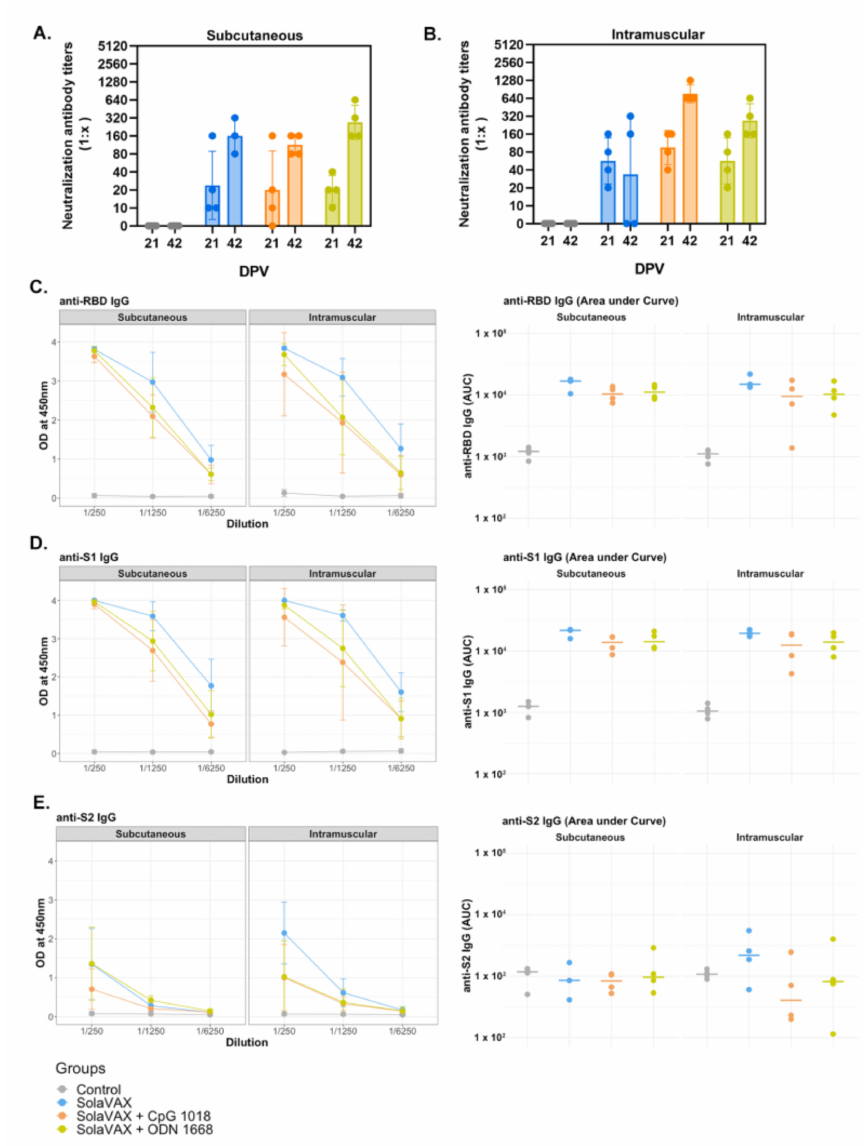
Figure 3. The detection of neutralizing antibodies in hamsters by PRNT90 after vaccination ( A , B ), and serum reactivity to spike protein’s RBD, S1 and S2 region ( C – E ). A plaque reduction neutralization test with a cutoff of 90% was used to determine neutralizing antibody production after 21and 42 days post vaccination (DPV) for both SC ( A ) and IM ( B ) routes of vaccine administration. The prime vaccination was given at 0 DPV and a booster vaccination given at 21 DPV. Data points represent group mean +/ − SD. Results of ELISAs measuring serum reactivity to RBD ( C ) and S1 ( D ) and S2 ( E ) protein. Graphs on the left panel shows optical density (OD) at 450 nm ( y -axis) vs. serum dilutions ( x -axis). Values represent mean +/ − SD, n = 4. Right panel shows area under the curve (AUC) calculated for each dilution for individual